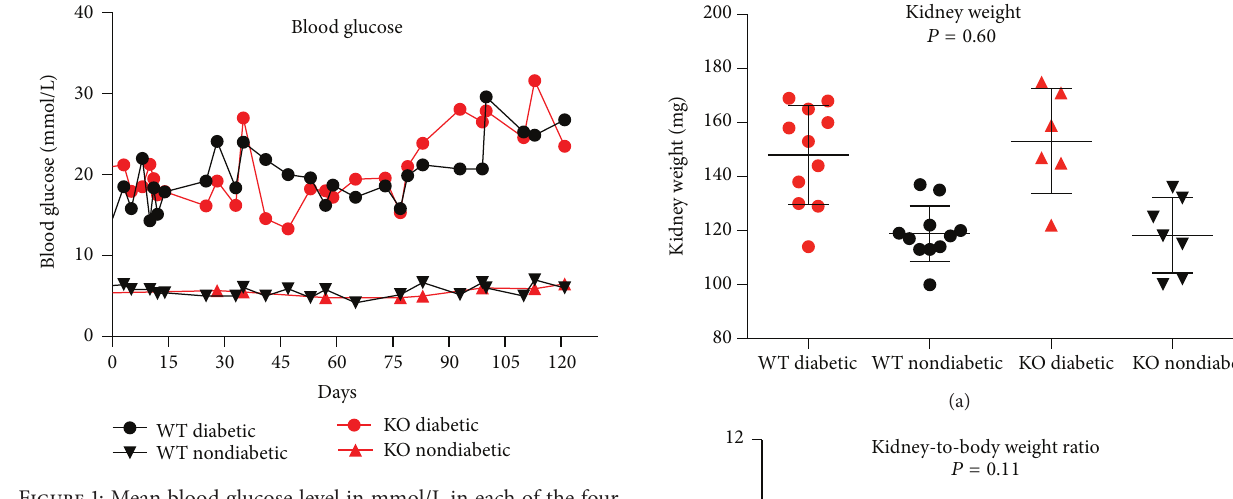
Figure 1: Mean blood glucose level in mmol/L in each of the four groups over time.